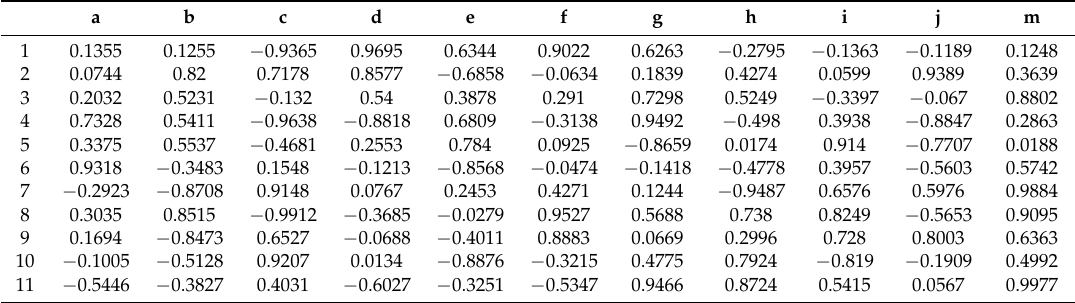
Table 5. The coefficient of the second hidden parameters and the first hidden parameters’ quantitative formulae.